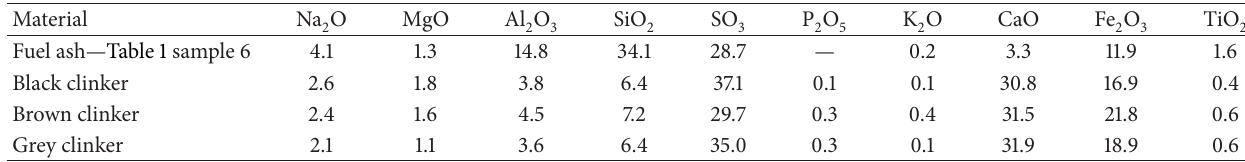
Table 2: Cyclone outlet standpipe blockage—chemical composition of fuel ∗ ash and